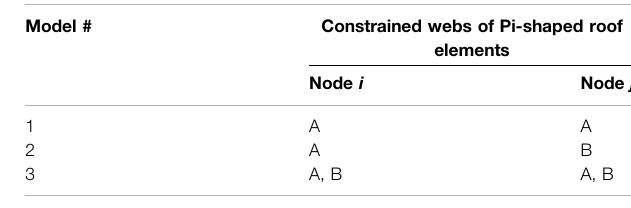
TABLE 2 | FE models of the bulding in Figures 12A,B obtained for different methods of connection of the precast Pi-shaped roof elements with the main beams.